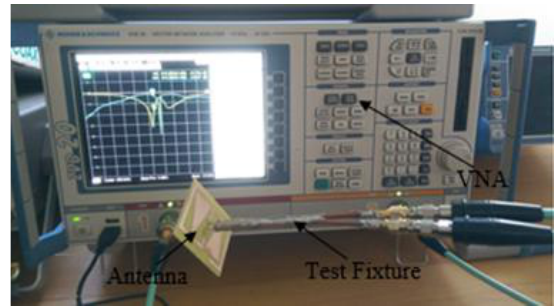
Figure 5: Measurement setup using Rohde & Schwarz ZVB 20 VNA with test fixture soldered to the antenna The antenna reflection coefficient is then extracted from the measured S-parameters over the frequency band of interest using the same method reported in [17]. Figure.6 shows the measured and simulated reflection coefficient of the RFID tag antenna. There is a good agreement between the measured and simulated results. The measured -10dB bandwidth is ranging from 900 MHz to 928 MHz for a total bandwidth of 28 MHz and is centered at 0.914 MHz, which can cover totally the North-American UHF RFID band.